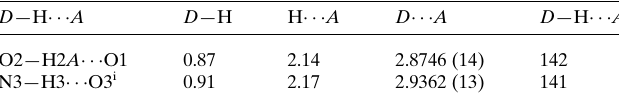
Table 1 Hydrogen-bond geometry (A˚ , (cid:3) ).